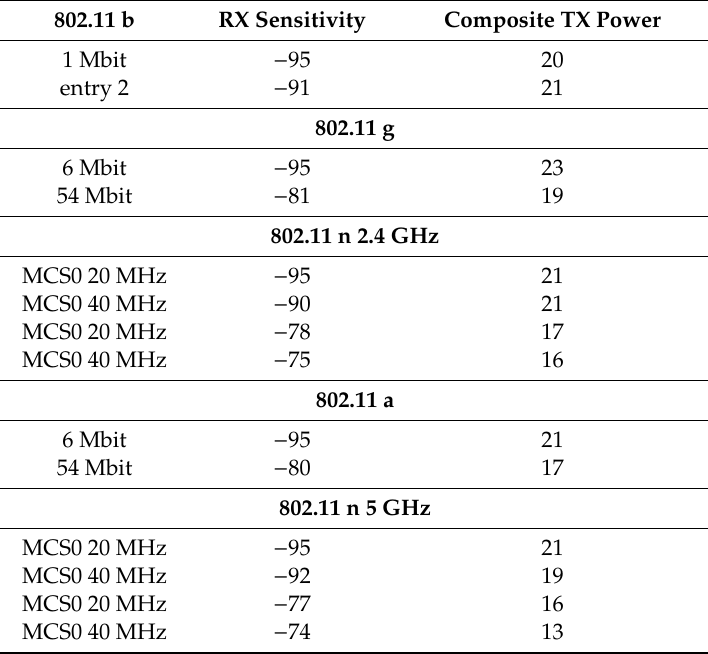
Table 9. Characteristics of the board Router BOARD